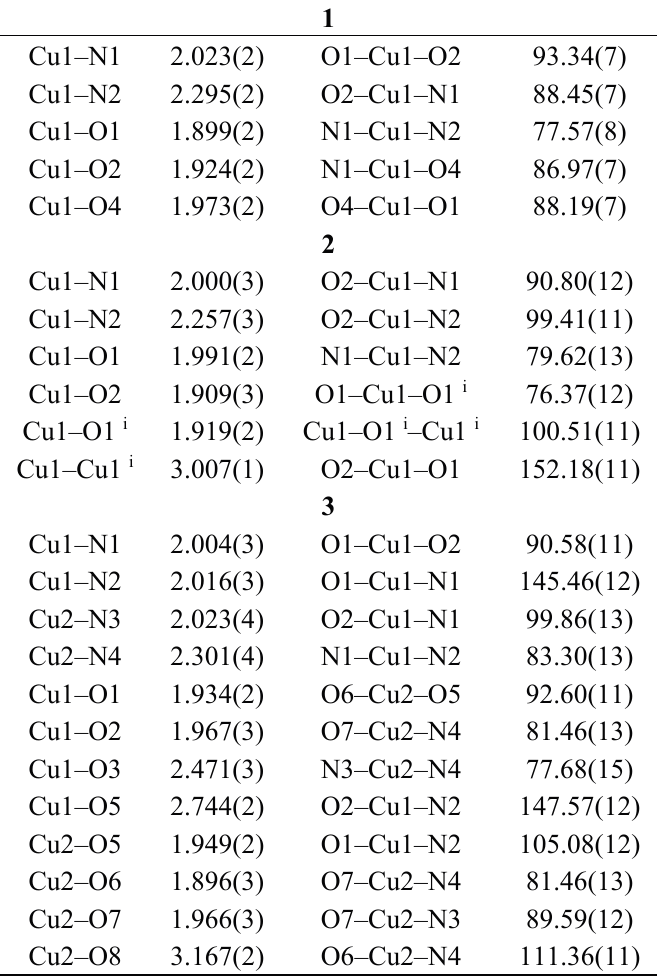
Table 1. Selected bond lengths (Å) and angles (°) for compounds 1 , 2 and 3